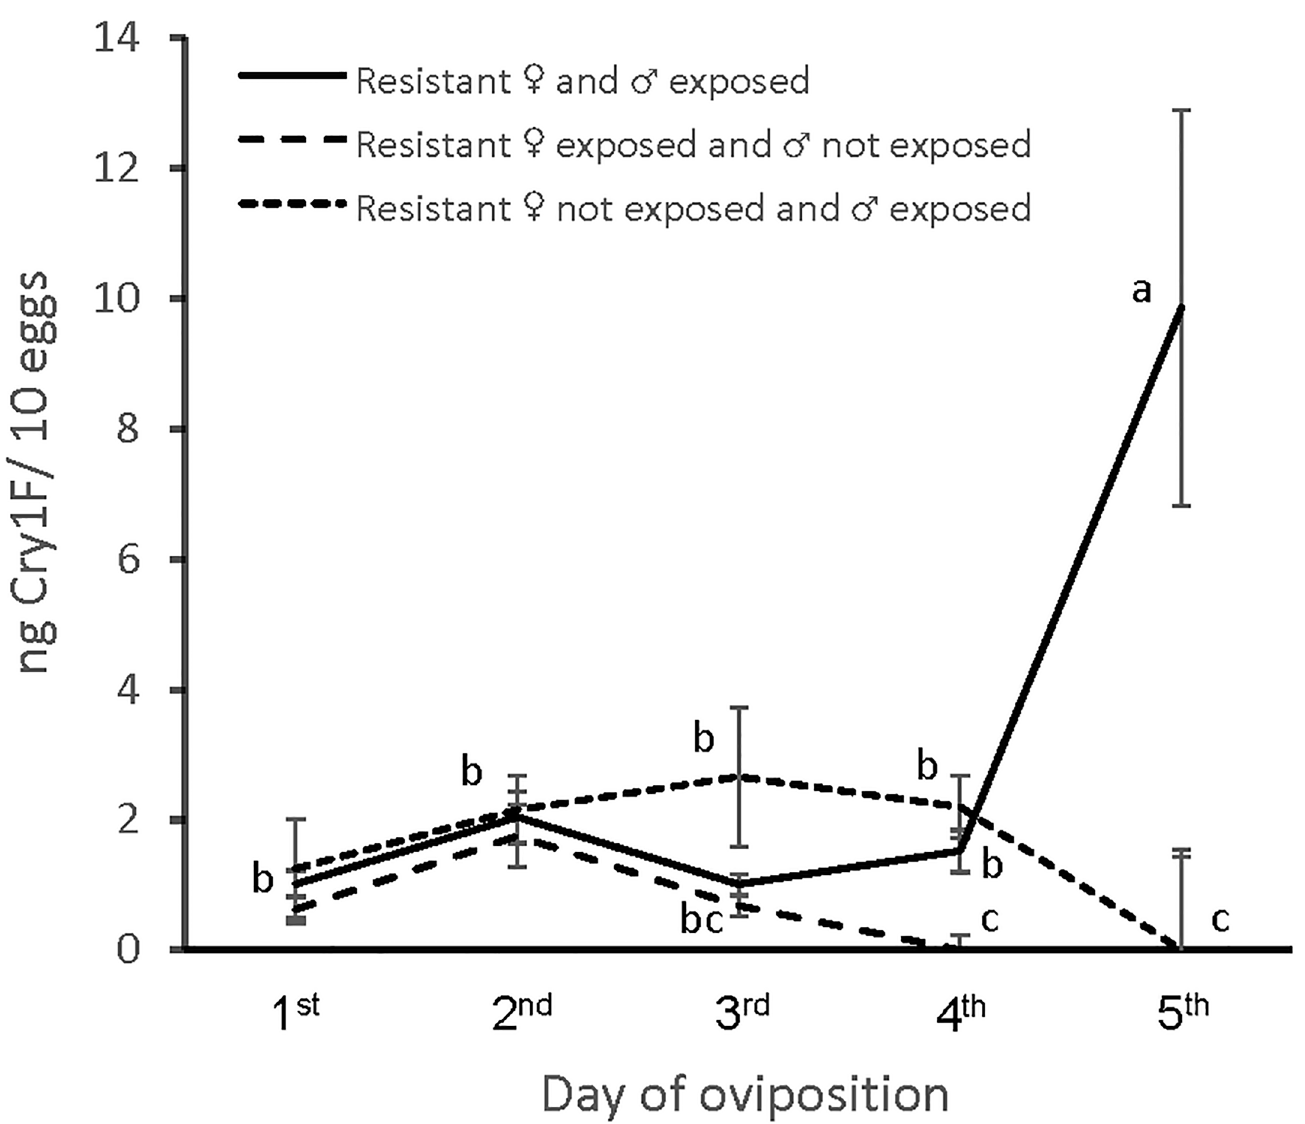
Fig 1. Cry1F concentration (ng/10 eggs ± 95% CI) detected in Spodopterafrugiperda eggs when parents were exposed or not to Cry1F as larvae from ten days after eclosion until pupation ( n = 10 couples/treatment). Treatment x day of oviposition effect: F 12,144 = 5.17, P = 3.57 x 10 −7 . Means for the treatment x day of oviposition interaction followed by the same letter did not differ according to the Tukey’s HSD test.